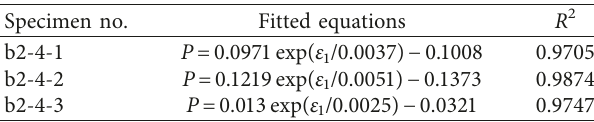
Table 8: The fitted formulas of cumulative energy dissipation coefficient and axial